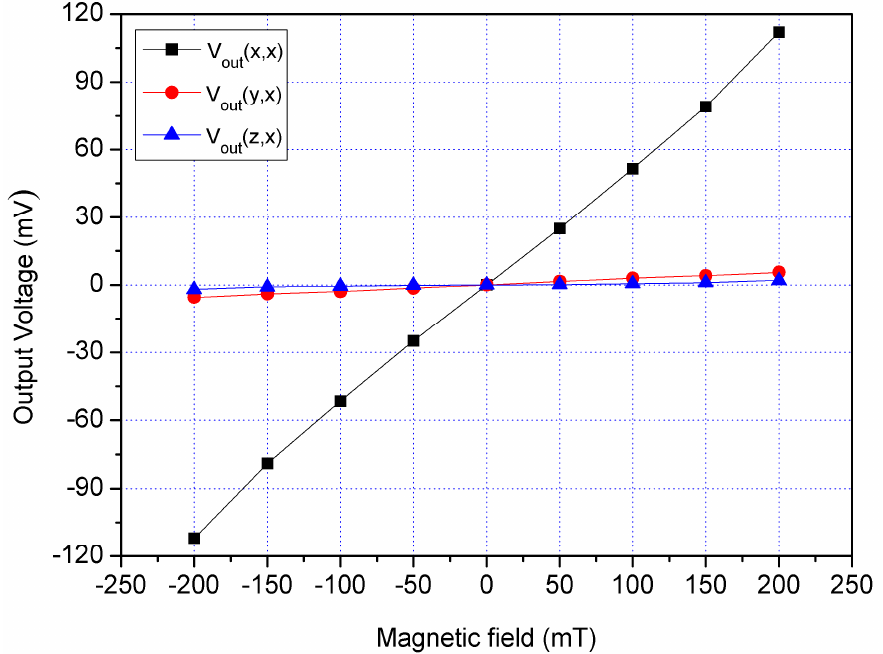
Figure 18. Measured Vo for the MS in the x-direction MF.